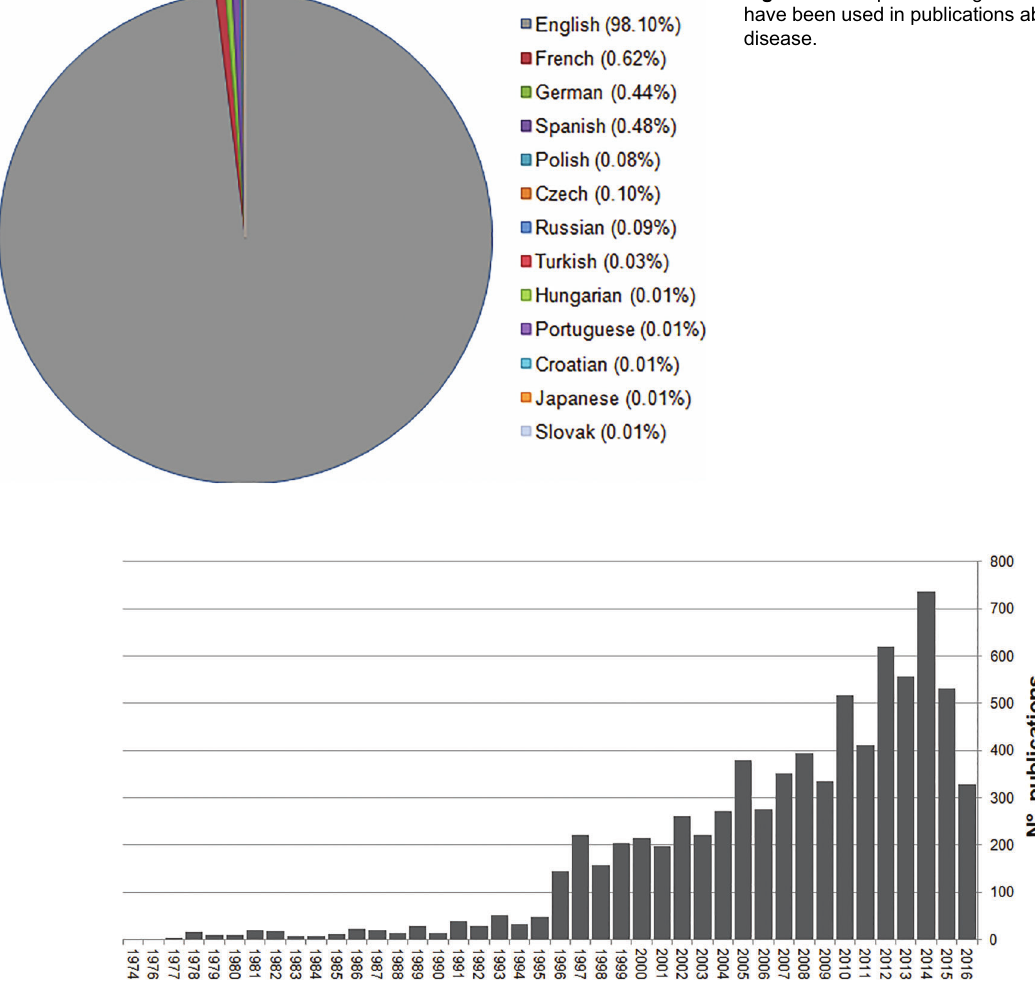
Figure 3. Number of articles on Huntington disease published each year from 1974 to